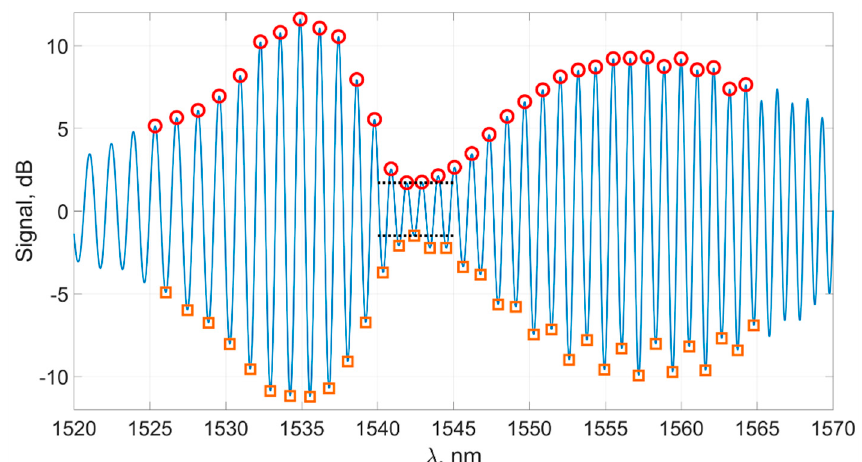
Figure 10. The filtered spectrum of the sensor’s signal with detected peaks lying in the region of the plasmon resonance wavelength: the upper group Ext top (circles), the lower group Ext bot (squares), and the amplitude of the constriction (dotted).